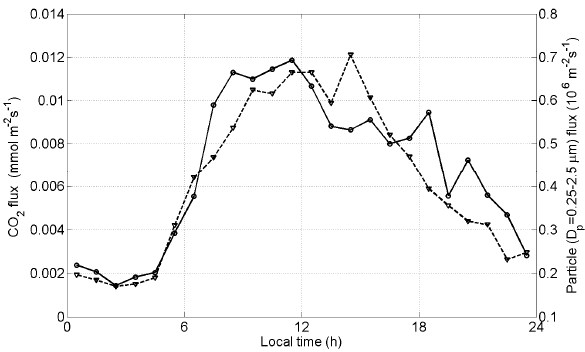
Fig 3: Median diurnal cycles of aerosol number flux within the total OPC size range (solid line) Fig. 3. Median diurnal cycles of aerosol number flux within the and CO 2 flux (dashed line) for the North sector. total OPC size range (solid line) and CO 2 flux (dashed line) for the North